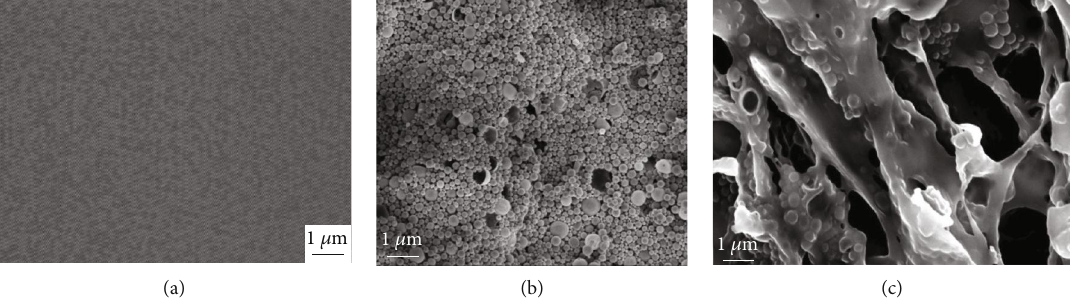
Figure 42: Microscopy images for MC4 (a) optical microscopy after washing the PVA (400 × magni fi cation), (b) SEM after washing the PVA (5000 × magni fi cation), and (c) SEM without washing the PVA (2300 × magni fi cation) [123].